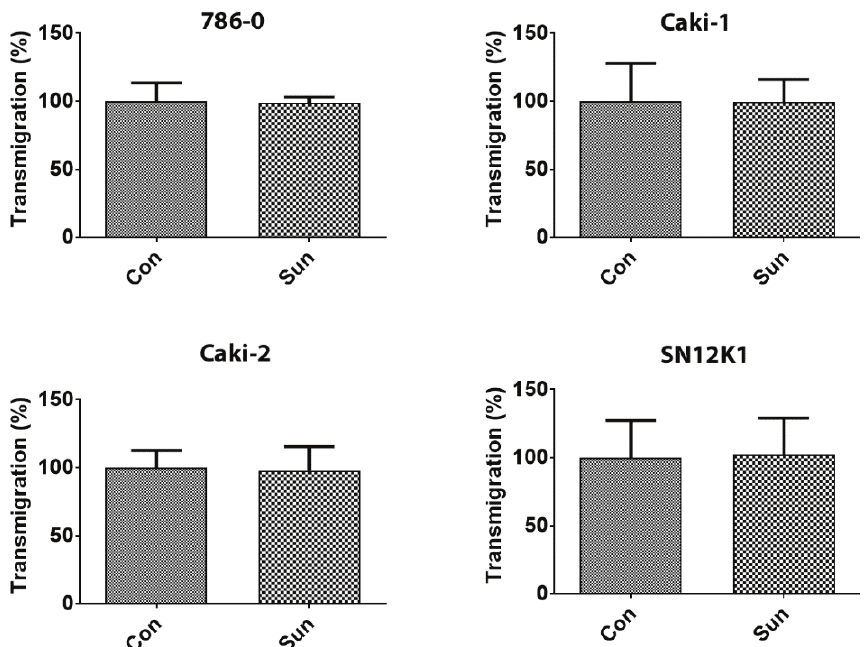
Figure 5. Lack of difference in transmigration between control and sunitinib-resistant cells. After 24 h of transmigration, in response to 10% FBS as a chemoattractant, no statistically significant difference was observed between the parental and sunitinib-resistant cells. Results are expressed as percentage of